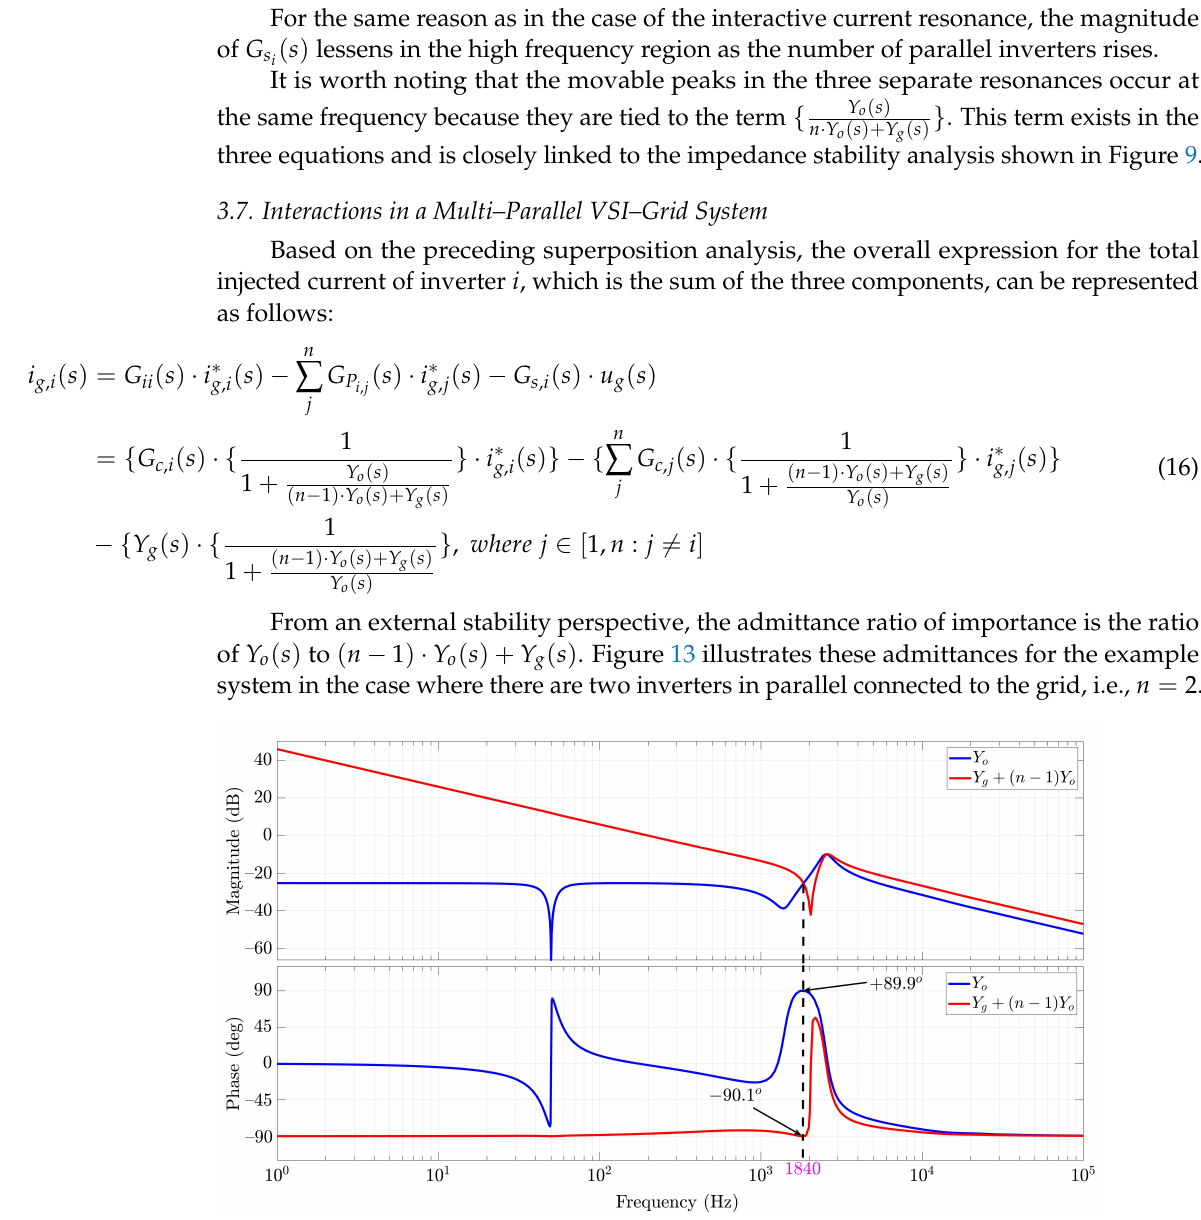
Figure 13. Bode plot of admittances of two identical parallel VSIs connected to the grid. Here, the intersection point of the admittances occurs at 1840 Hz with a phase margin angle φ PM = zero , as depicted in Figure 13. The injected grid current in Figure 14a is distorted by this harmonic component of 1840 Hz. Furthermore, this harmonic resonance frequency dominates the grid current’s harmonic spectrum, as seen in Figure